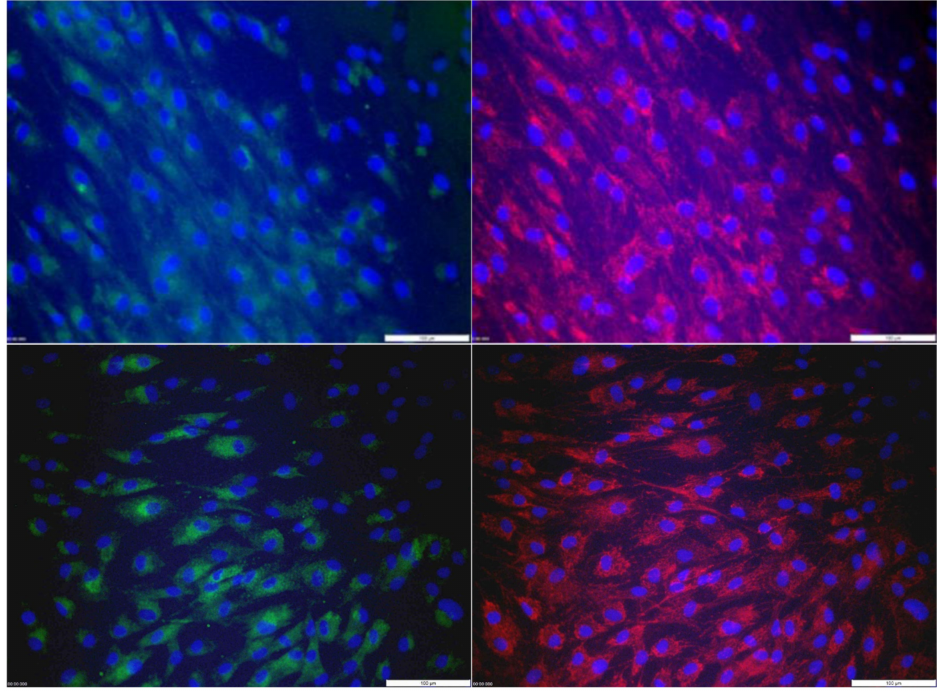
Figure 7. ATP6 immunostaining ( left panels ) and Mitotracker TM staining ( right panels ) counter- stained with DAPI of P2 (two upper panels ) and a control sample (two bottom panels